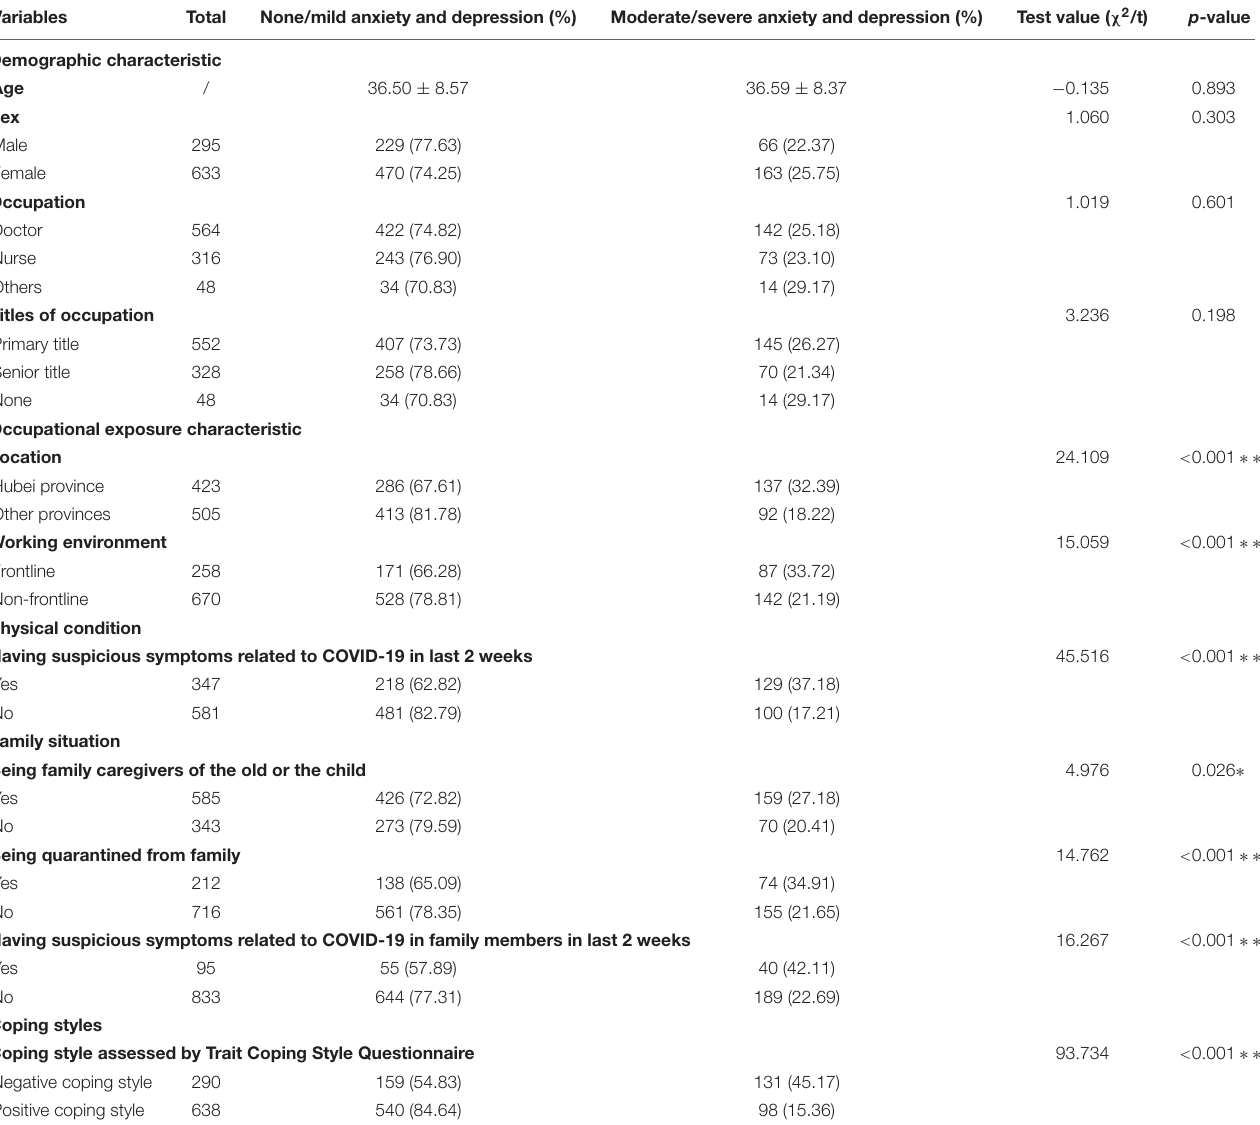
TABLE 1 | General characteristics of participants according to ADSs ( n =